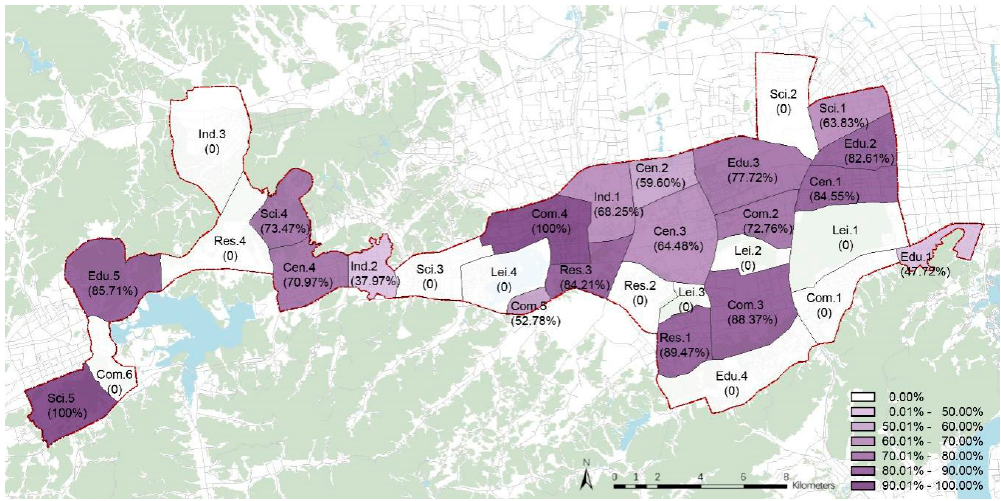
Figure 9. Proportion of happy commuters in each area in the Corridor.